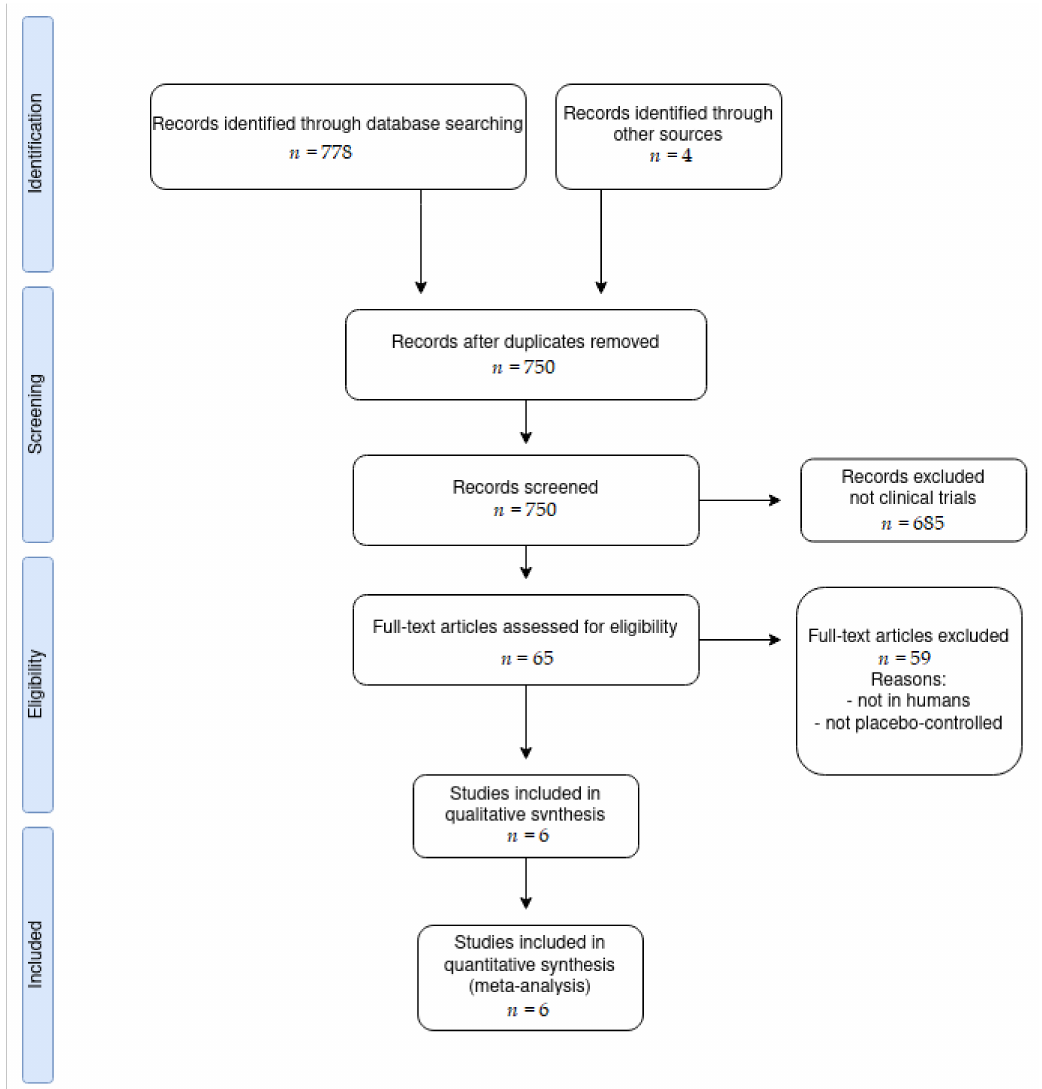
Figure 1. Flow chart of the process of study